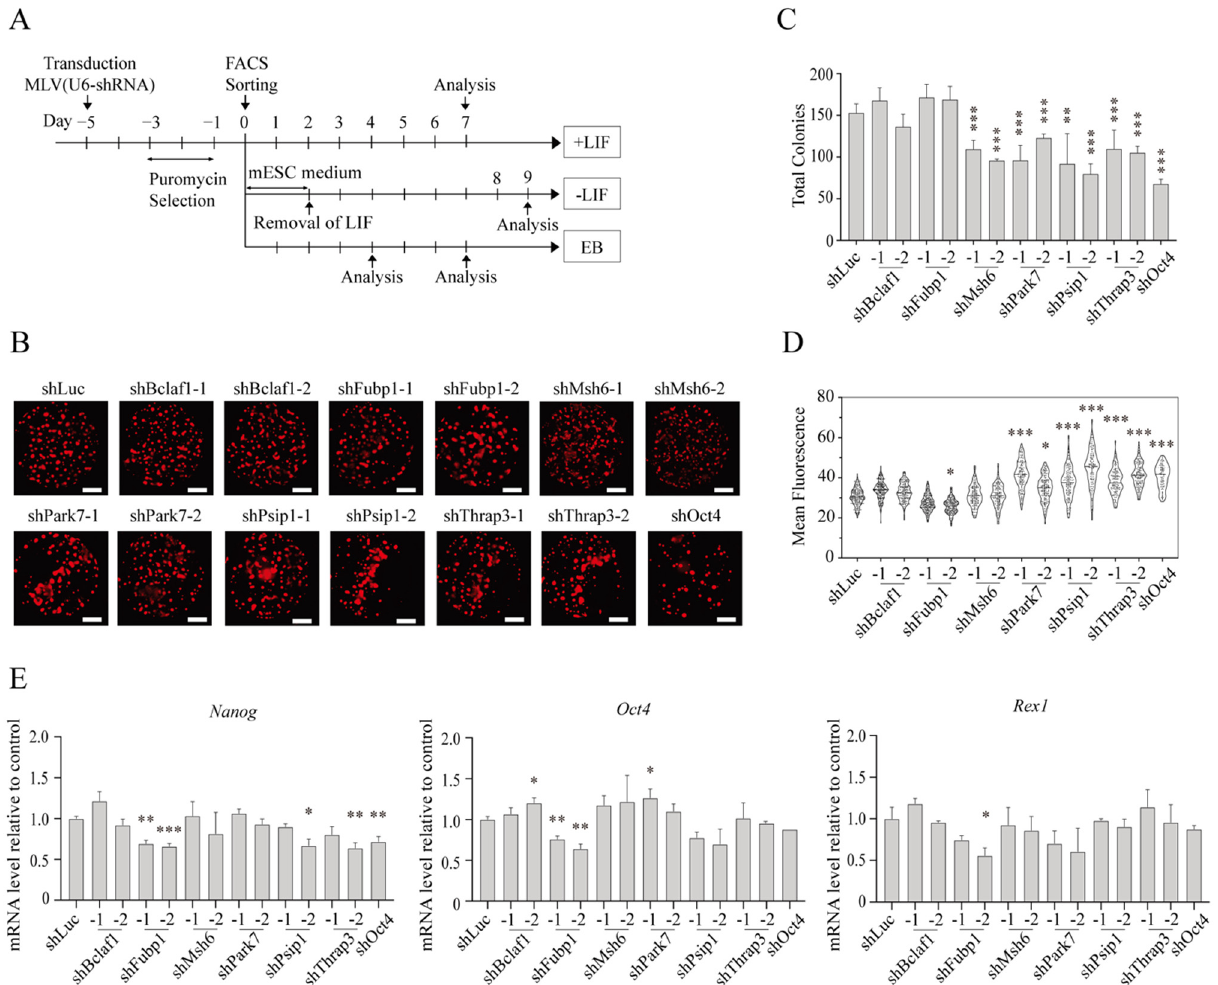
Figure 3. The effect of knockdown of identified proteins on self-renewal and pluripotency of mESCs. ( A ) Experimental scheme of pluripotency and differentiation analyses. EB5/ReKO cells were trans- duced with retroviral vector expressing each shRNA followed by puromycin selection for 2 days. Five days after transduction, 1000 cells/well were sorted to a flat-bottom 96-well plate for culture in mESC medium with Leukemia Inhibitory Factor (+LIF) or without (-LIF) LIF, or 1 × 10 3 cells/well to V-bottom 96-well plate for embryoid body (EB) formation (EB). ( B ) Whole well fluorescence images of hKO(+) mESC colonies cultured with LIF. EB5/ReKO cells treated with indicated shRNA and cultured in mESC medium with LIF. Whole well images were collected 7 days after sorting. Repre- sentative images are shown. Scale bars, 1500 µm. ( C ) Colony numbers of mESC treated with shRNA. Colony numbers were counted from the images collected in ( B ). Data represent the mean ± SEM from five independent experiments. ** p < 0.01, *** p < 0.001 versus EB5/ReKO cells treated with control shRNA (shLuc). ( D ) Mean fluorescent intensity of mESCs treated with shRNA. hKO fluo- rescent intensity in each colony was measured from the images collected in ( B ). Data represent the mean ± SEM from total colonies in each shRNA. * p < 0.05, *** p < 0.001 versus EB5/ReKO cells treated with control shRNA (shLuc). ( E ) mRNA level of pluripotency-related genes. Nanog , Oct4 , or Rex1 mRNA levels in the EB5/ReKO cells prepared as ( B ) were determined 7 days after cell sorting. Data represent the mean ± SEM of three independent experiments. * p < 0.05, ** p < 0.01, *** p < 0.001 versus EB5/ReKO cells treated with control shRNA (shLuc).